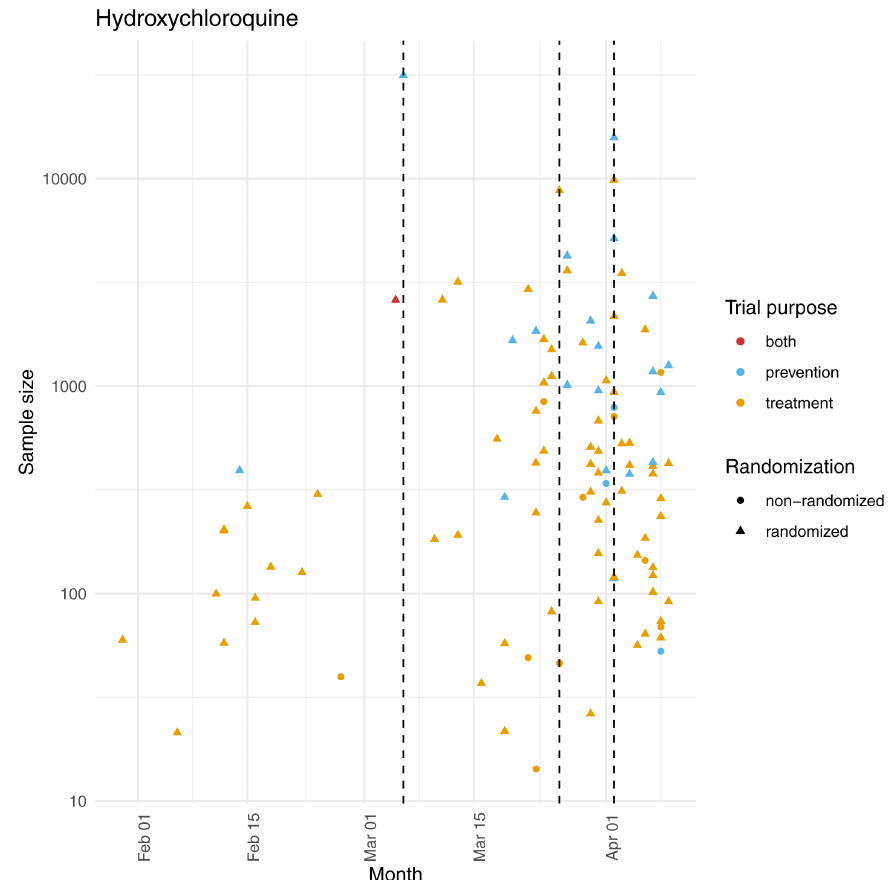
Figure 4. The 110 Trials assessing hydroxychloroquine for COVID-19 registered in the first 100 days of the pandemic. The dashed lines represent the registration of the four trials planning to enroll over 5,000 participants; two were registered on April 2, 2020. Out of the four trials planning on enrolling over 5,000 participants, two assessed hydroxychloroquine for treatment and two for prevention. Out of the 104 smaller trials, 82 assessed hydroxychloroquine for treatment, 21 for prevention and one for both treatment and